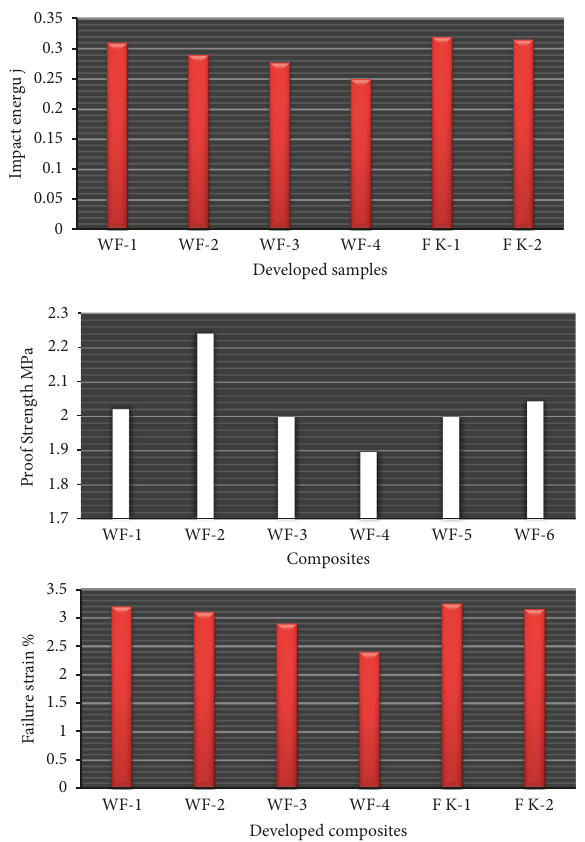
Figure 6: Impact energy and ash proof strength and failure strain of newly developed